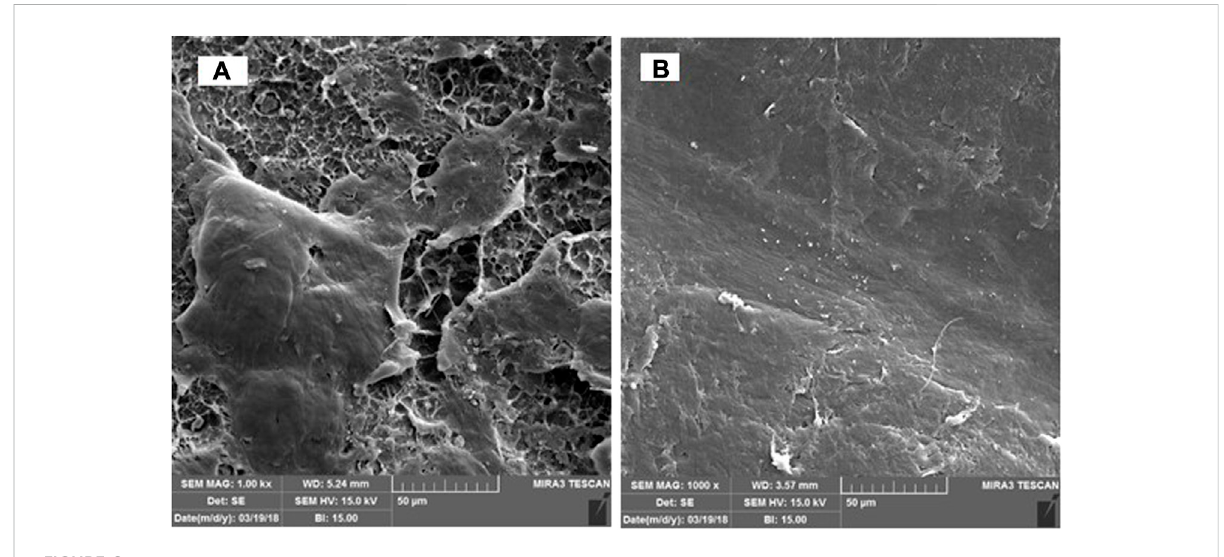
FIGURE 6 The SEM image of fresh (A) used 2H media in SBBR (B)